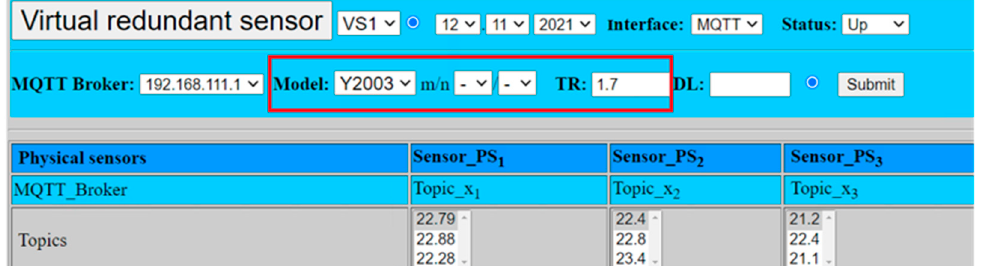
Figure 13. Emulated physical sensors connected to virtual sensor.